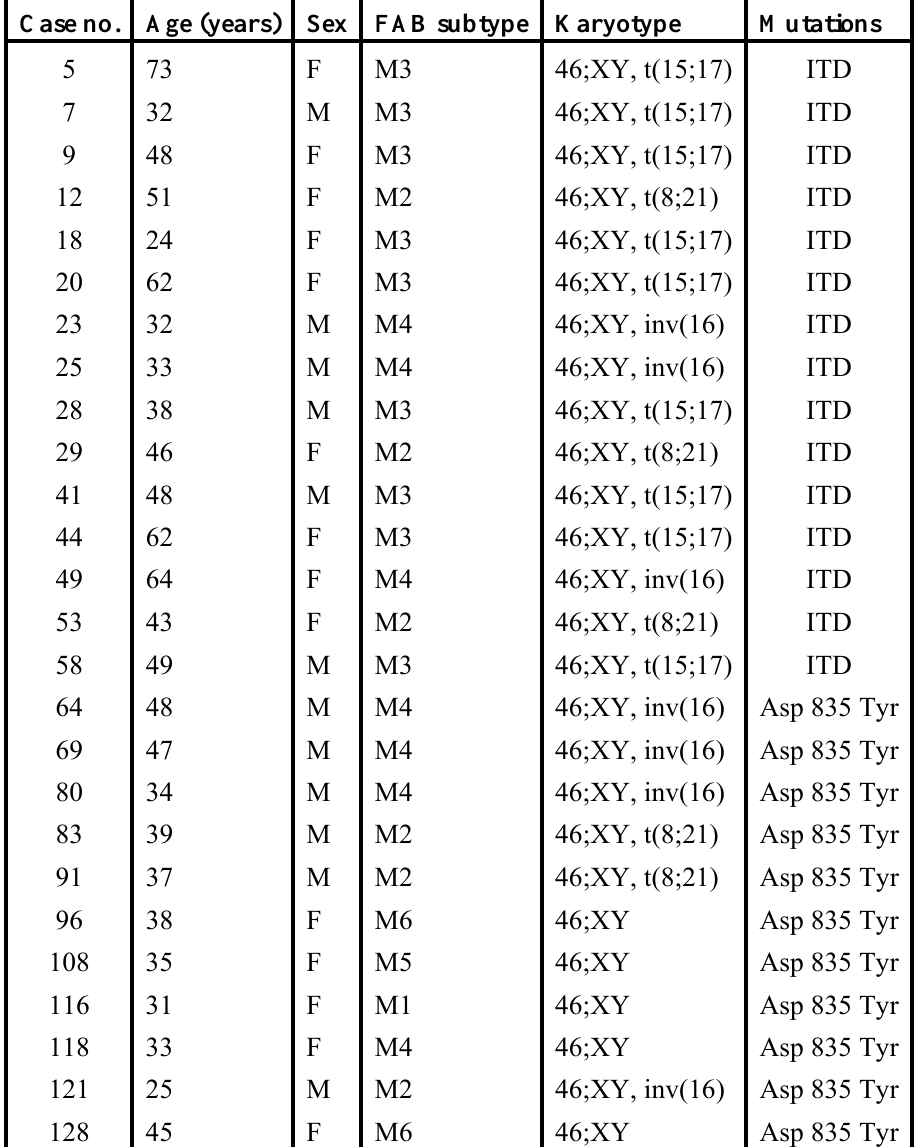
Table 1. Clinical characteristics of AML cases and accompanied mutations. Case